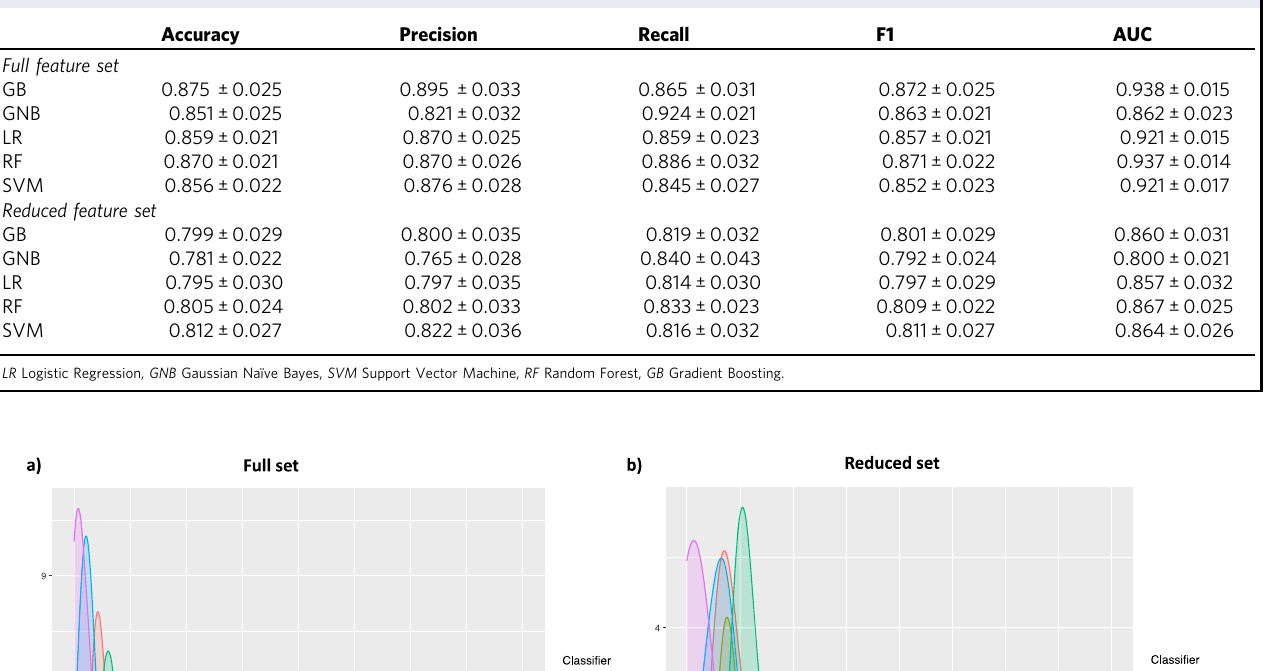
Table 1 Model performance based on 10-fold cross-validation.